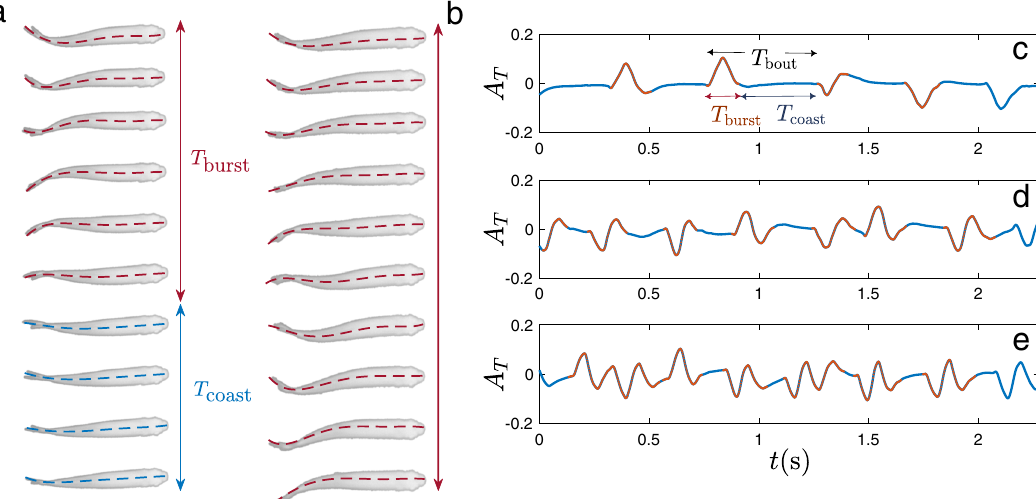
Fig. 1 Burst-and-coast kinematics. a, b Sequence of snapshots of typical swimming cycles for two different imposed swimming speeds, a : U = 1.15 BL/s and b U = 1.9 BL/s . Time goes from top to bottom. The swimming cycle is composed of burst and coast phases. During the burst phase, the fi sh produces propulsion by undulating its body, while during the coast phase the fi sh pauses and glides thanks to its own inertia. As can be seen, the main difference in kinematics between the two gaits ( a ) and ( b ) is the time ratio between the propulsive action and the pause. The fi rst part of the swimming cycles are similar, with comparable beating frequency and amplitude of the body undulation but the fi sh swimming at the larger speed in ( b ) continues beating for the full cycle while the other pauses before the next one. The midline extracted from the video post-processing is superposed to each frame. c – e Typical tail-tip kinematics extracted from video analysis for three different imposed swimming velocities. c U = 0.66 BL/s, d U = 1.15 BL/s, and e U = 1.9 BL/s. As can be observed, the intrinsic characteristics of the active burst cycle (in red color) share the same properties whatever the imposed gait. The frequency and amplitude of the basic tail beat are similar and the imposed velocity is sustained just by increasing linearly the burst time with respect to the pause time. Note that a tail-beat cycle consists of two strokes respectively towards each side of the body, thus in panel ( c ), a single stroke is counted as a half tail- beat